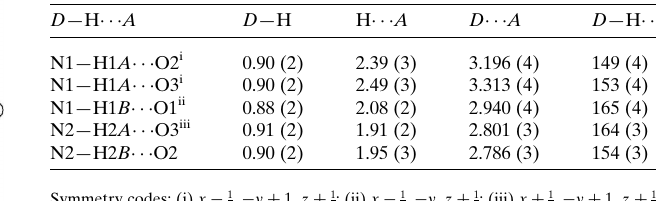
Table 1 Hydrogen-bond geometry (A˚ , (cid:4) ).